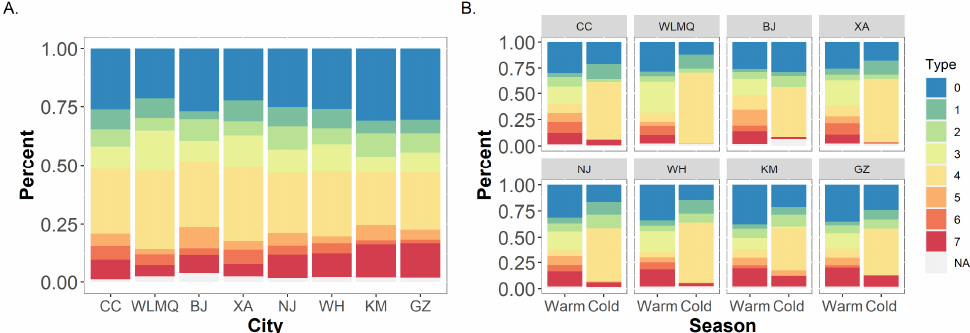
Figure 1. Frequency distribution of different pollution types in 8 cities (( A ) all-year results; ( B ) sea- sonal results). The type of pollution and the pollutant classified as high level in this type are as